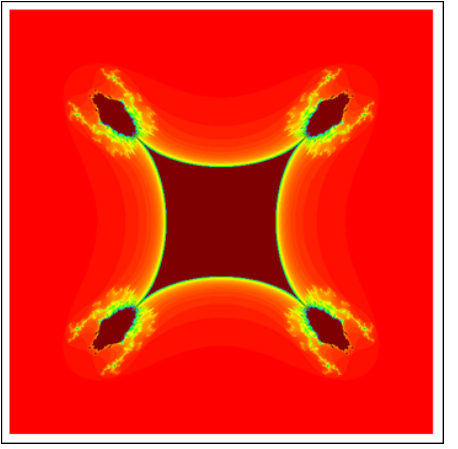
Figure 48. Multi-corn via F-iteration with image visual time = 66.3 s.